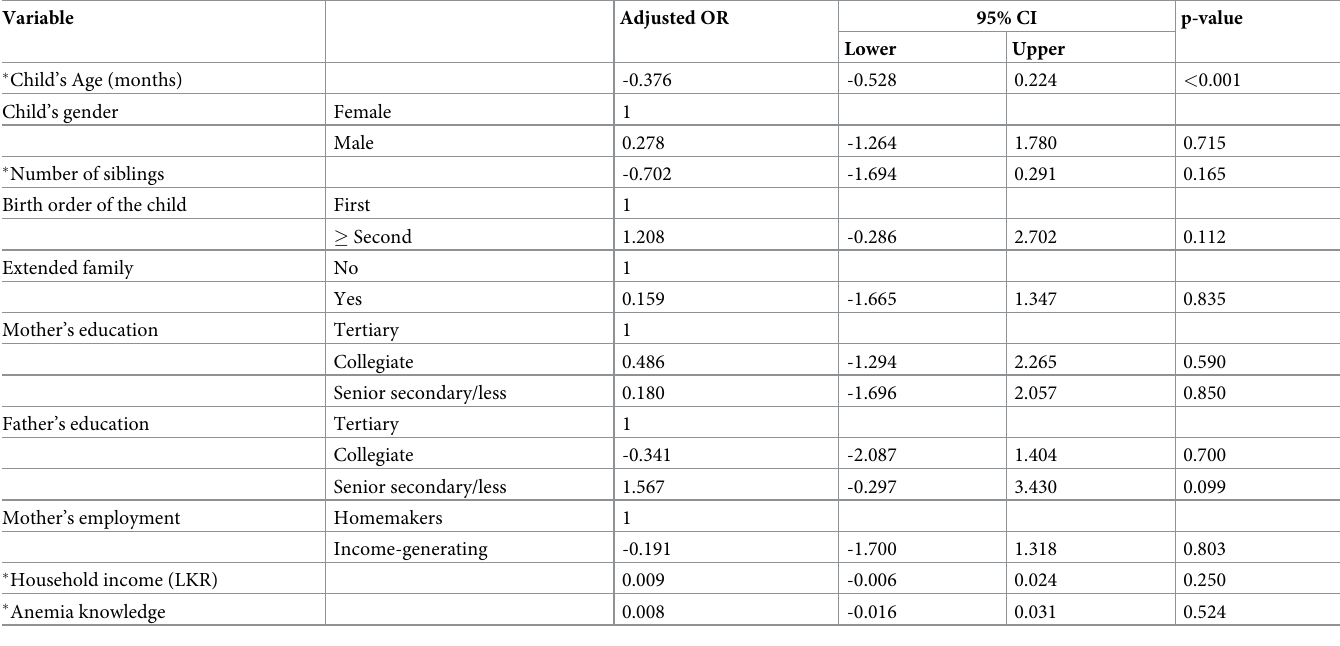
Table 4. Univariate analysis of factors affecting acceptability.